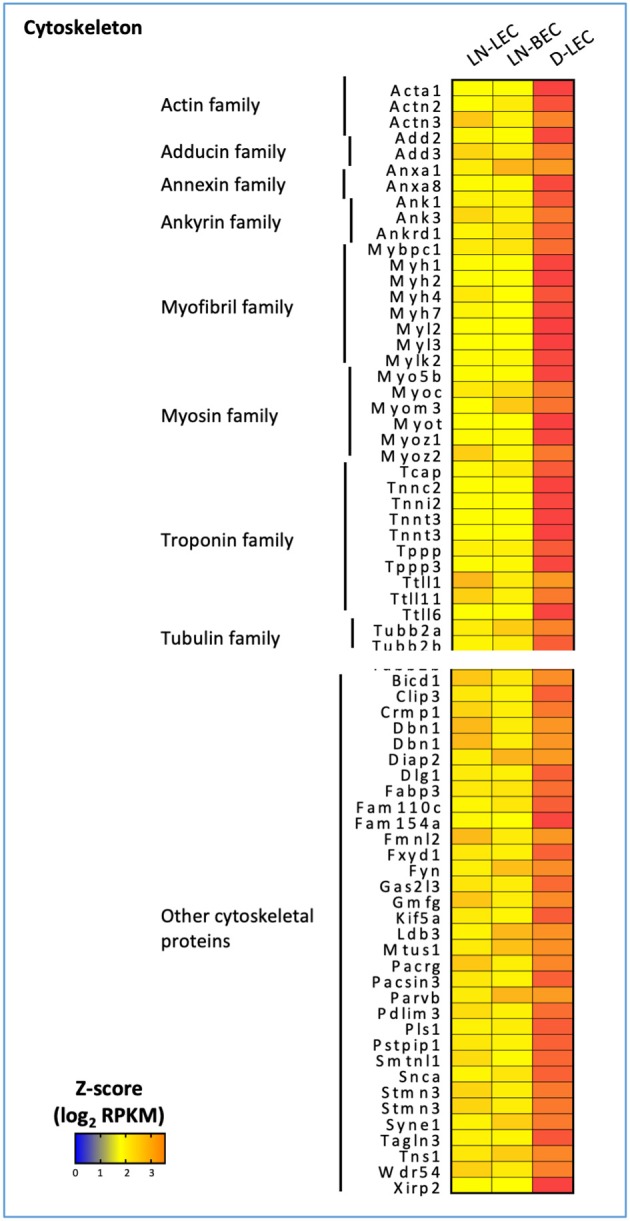
5X-DEG in D-LEC only subset showed enriched representation of different cytoskeletal protein groups compared to other 5X-DEG subsets. Heatmap analysis based on Z-score values of average log2 FPKM for replicates in each cell type (details in Methods).